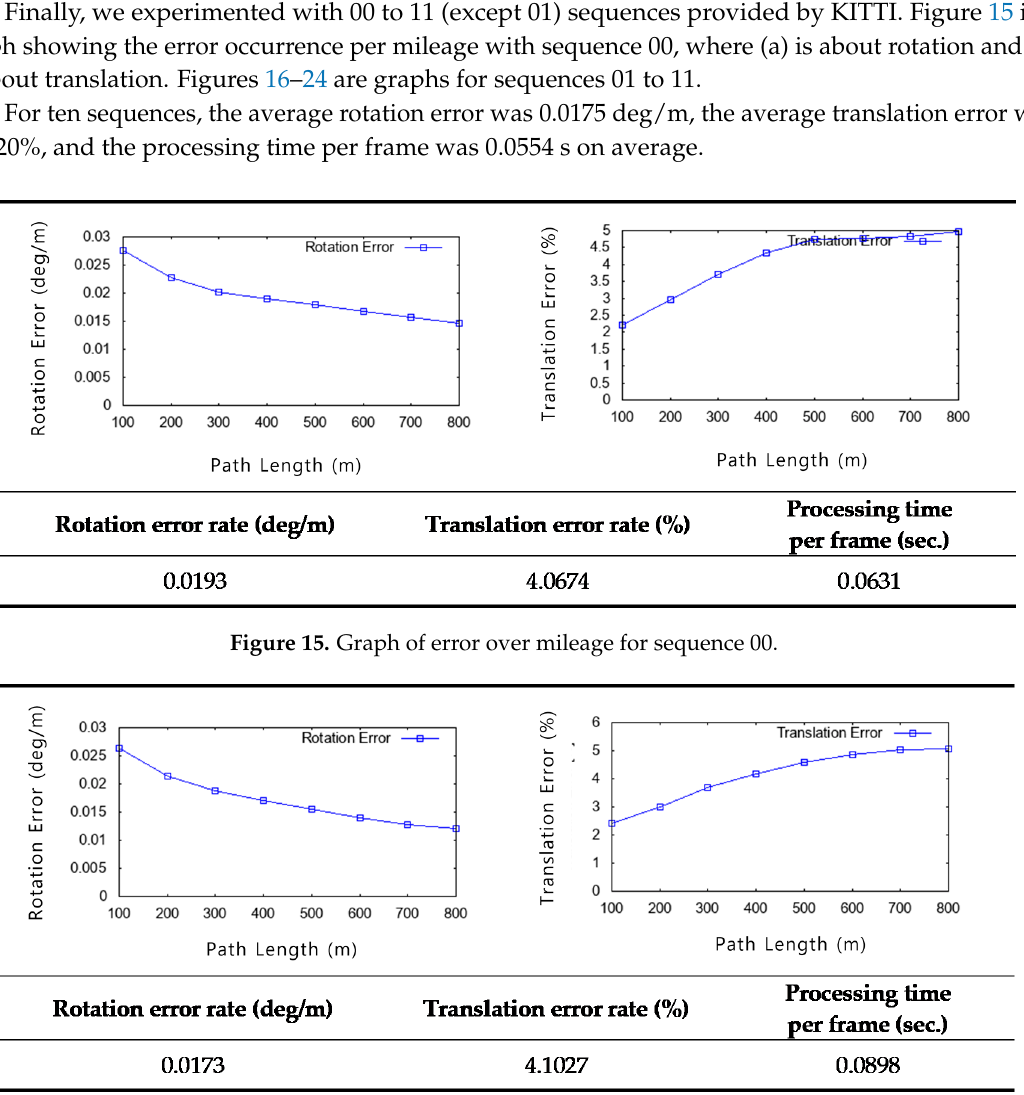
Figure 16. Graph of error over mileage for sequence 02.